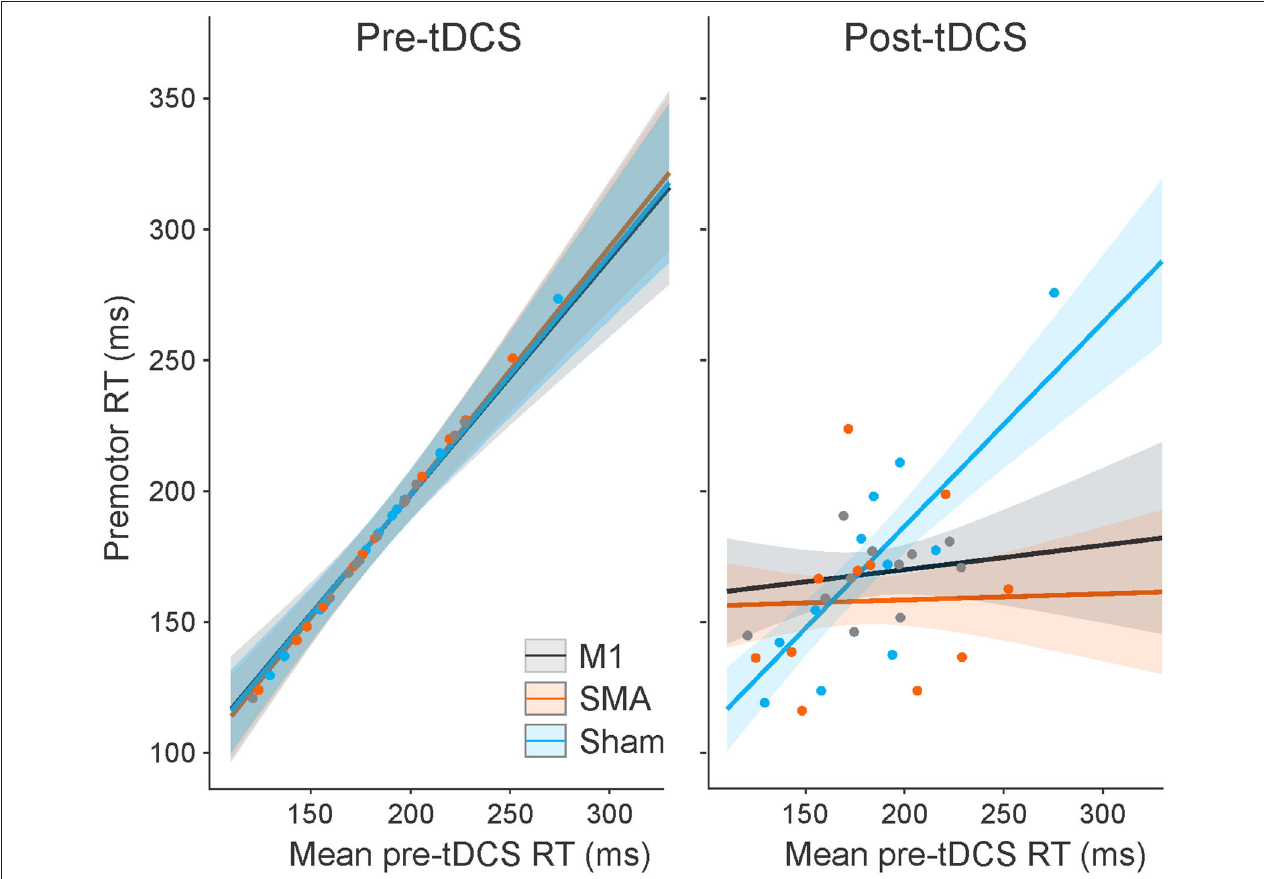
FIGURE 2 | Model-fitted predicted control trial premotor reaction time (RT) collapsed across tasks as a function of mean pre-tDCS control RT for each tDCS session (M1 = a black line; SMA = an orange line; sham = a blue line). The left panel shows pre-tDCS data, and the right panel shows post-tDCS. Shaded areas represent 95% CI. Dots represent participant mean RT values in each tDCS session (note that these means are collapsed across tasks with different pre-tDCS mean RT values, and the models take all individual data points into